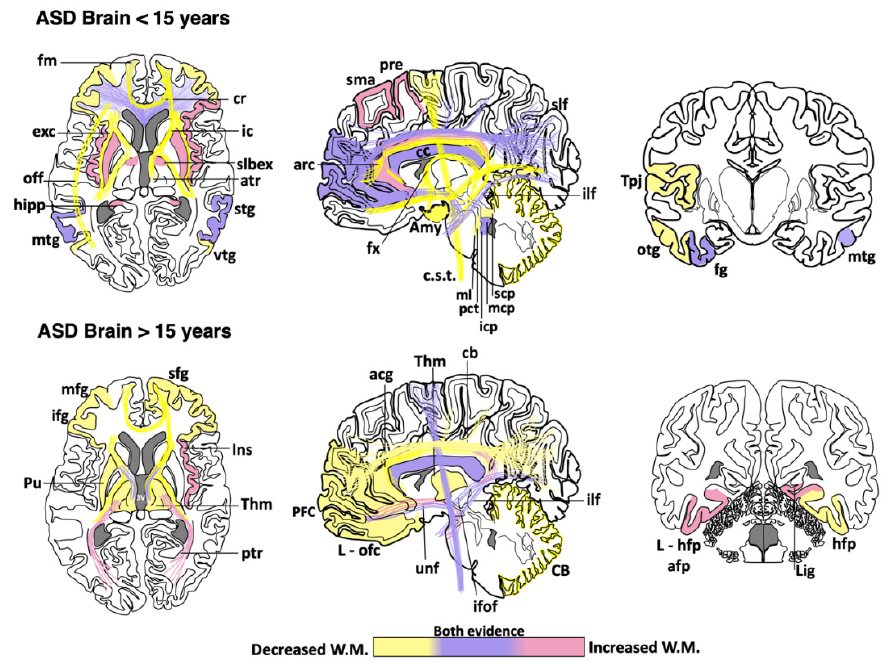
Figure 1. Cortical areas, subcortical areas and white matter tracts affected in patients with Autism Spectrum Disorder (ASD). White matter areas with the most noticeable changes are represented in the three anatomical planes of the human brain: axial, sagittal, and coronal, respectively. Brain schemes also indicate the most common myelination changes that occur in ASD patients during two different stages of development [21,30,36,60,64,65,67,70–109]. acg: anterior cingulate gyrus; afp: